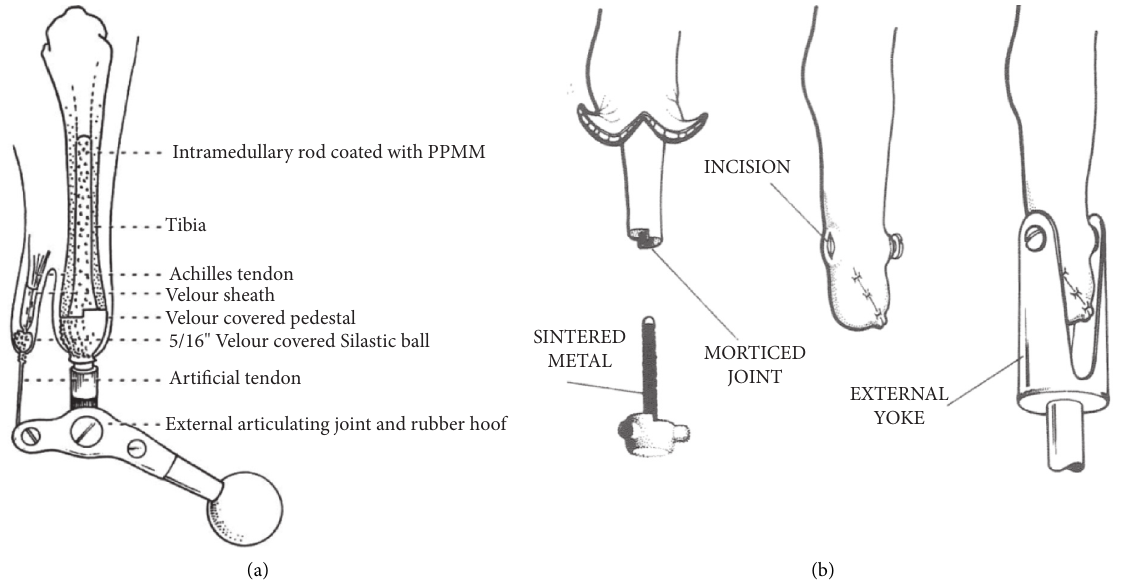
Figure 10: Notable designs by Charles William Hall. (a) Sketch of a 1975 attempt to preserve muscle-tendon control of the distal joint via a percutaneous artificial tendon. The inevitable artificial tendon rupture and issues with infection coming from the skin-bone interface led to this design’s abandonment. (b) The final design proposed by the Hall team featured an intramedullary central titanium textured nail with three perpendicular lug attachments. The bone end was mortised to match the implant junction in order to prevent rotation before osseointegration occurred. The skin was closed over the triflanged lugs. These three lugs were later connected to an external prosthesis yoke. A key design element was that the transcutaneous bolts that connected the internal implant to the yoke was at right angle to the skin, which Hall believed would minimize tension on the skin with limb movement and thus minimize irritation, inflammation, and eventual infection (figures adapted from public domain articles. (a) Hall, C. W. Permanently attached artificial limbs. Bull Pros Res. 1975 BPR 10–42 23: 321–327. (b) Hall, C. W. A future prosthetic limb device. J Rehab Res . July 1985; BPR 10–42